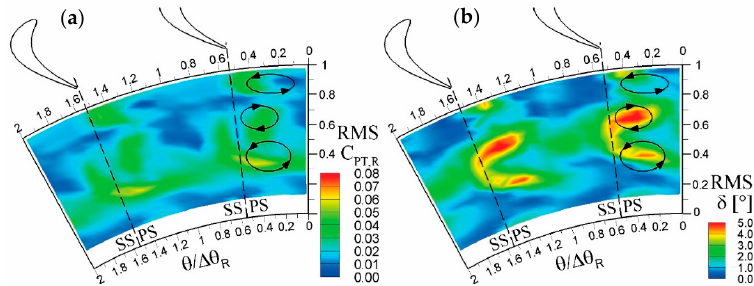
Figure 12. RMS of periodic unsteadiness for OP4, ( a ) RMS of the relative total pressure coefficient; ( b ) RMS of the deviation angle.